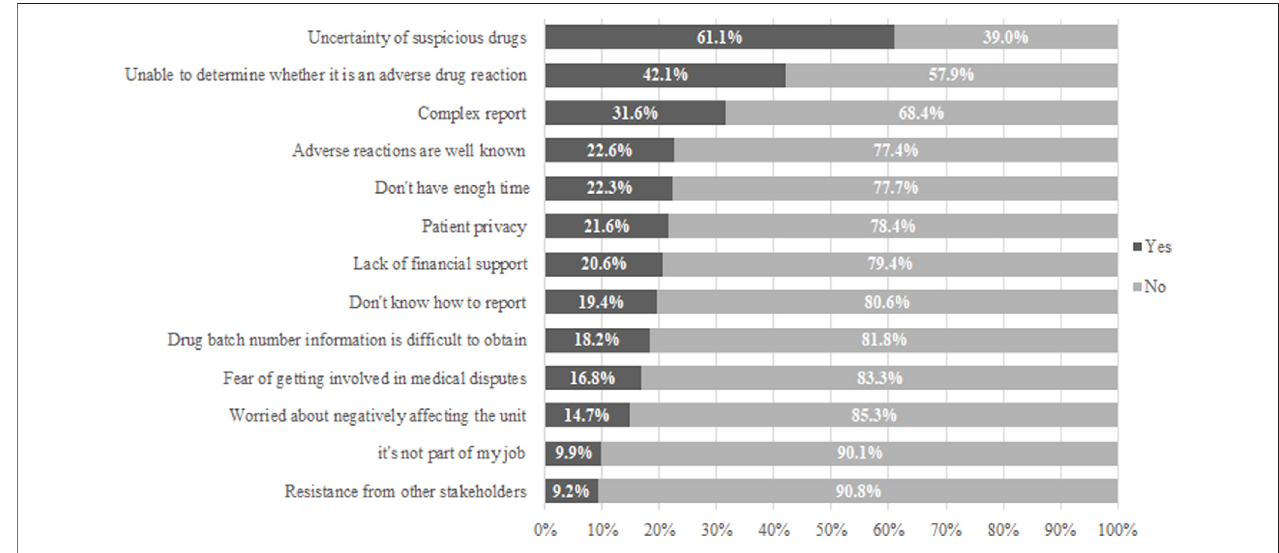
FIGURE 2 | Factors in fl uencing the reporting of ADR among